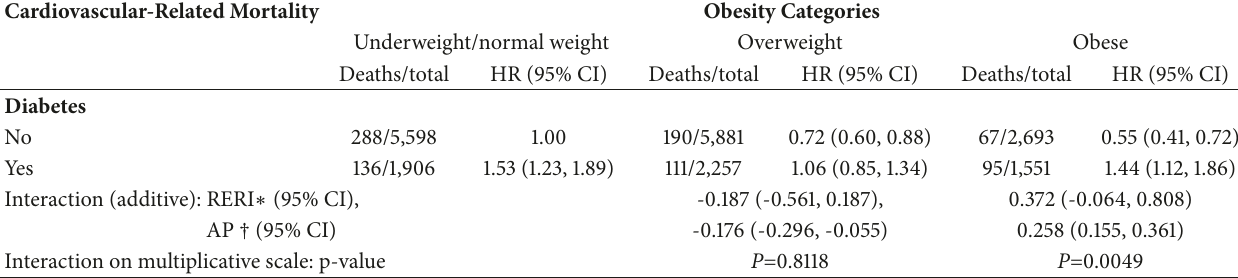
Table 4: Adjusted HRs (95% CIs) for cardiovascular-related mortality following an ischemic stroke in relation to categorical indicators of BMI and diabetes. Cardiovascular-Related Mortality Obesity Categories Underweight/normal weight Overweight